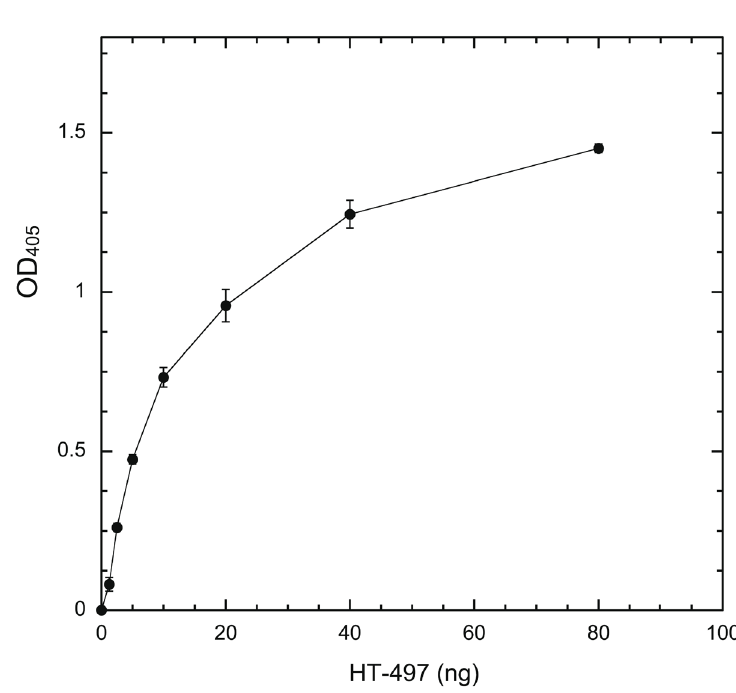
Figure 3. DYRK1A concentration-dependent phosphorylation of coated HT-PRD. Wells were coated with 200 ng/well HT-PRD and then subjected to DYRK1A phosphorylation with varying amounts of HT-497 (1.25, 2.5, 5, 10, 20, 40, and 80 ng) at 30°C for 30 min. The level